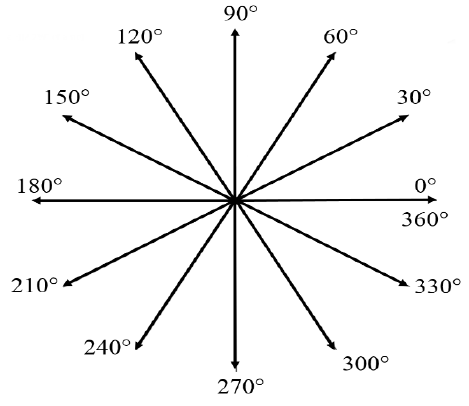
Figure 11. Switching conditions for the load transformer.